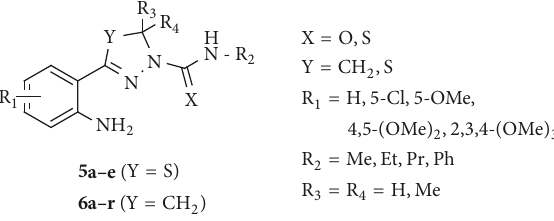
Figure 2: General structure of new derivatives (5a–e) and (6a–r)